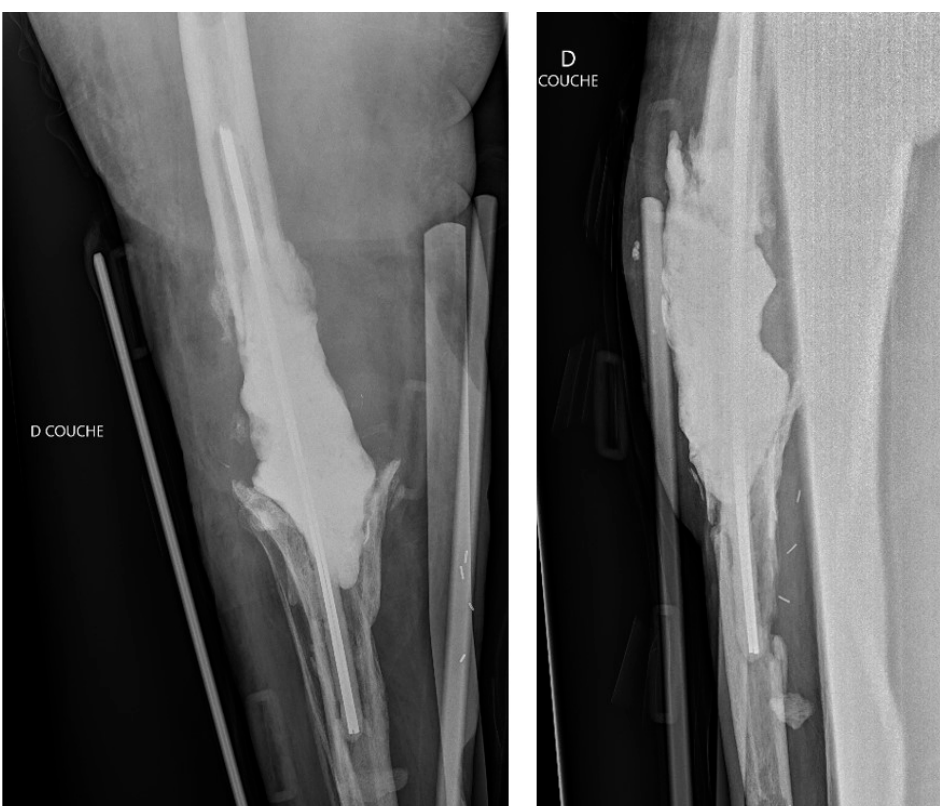
Figure 3. Anteroposterior and lateral post-operative radiographic views of the right knee after component explanation with an antibiotic-loaded cemented spacer, fixed with two metalic rods.